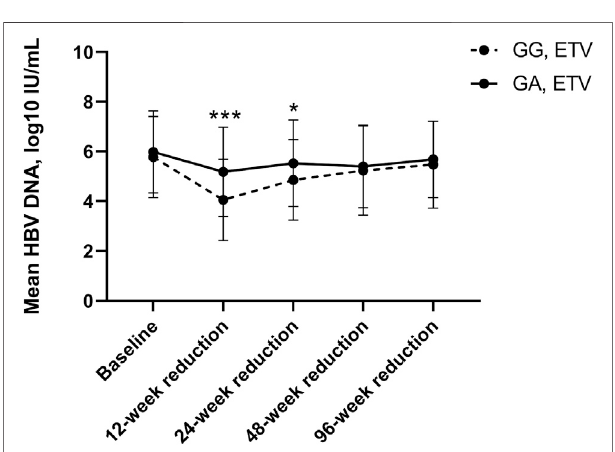
Frontiers in Pharmacology |